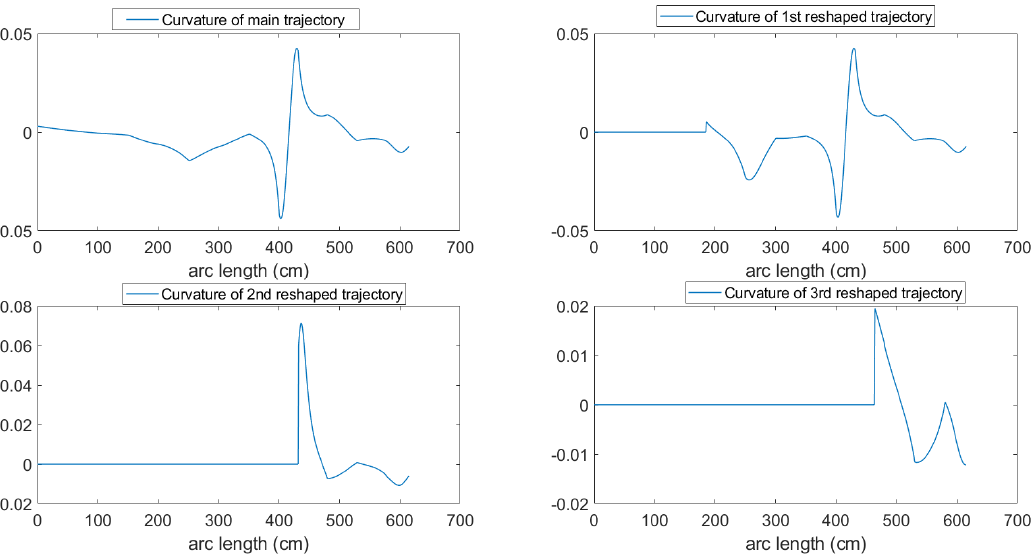
Figure 19. Trajectories’ curvature of the first scenario.